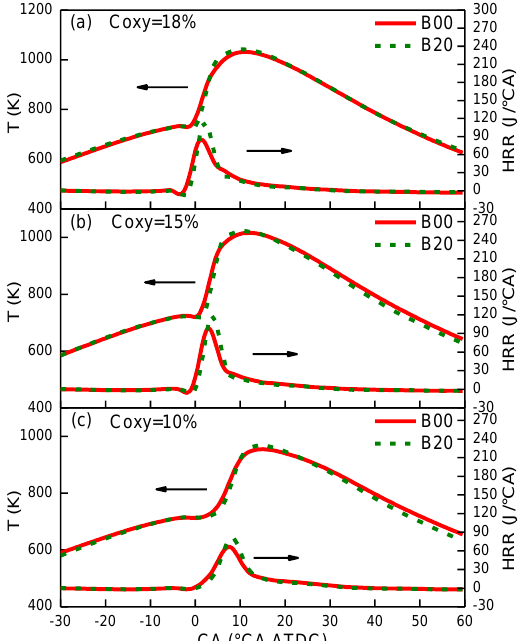
Figure 4. Average in-cylinder temperature and heat release rate at 18% ( a ), 15% ( b ), and 10% ( c ) intake oxygen